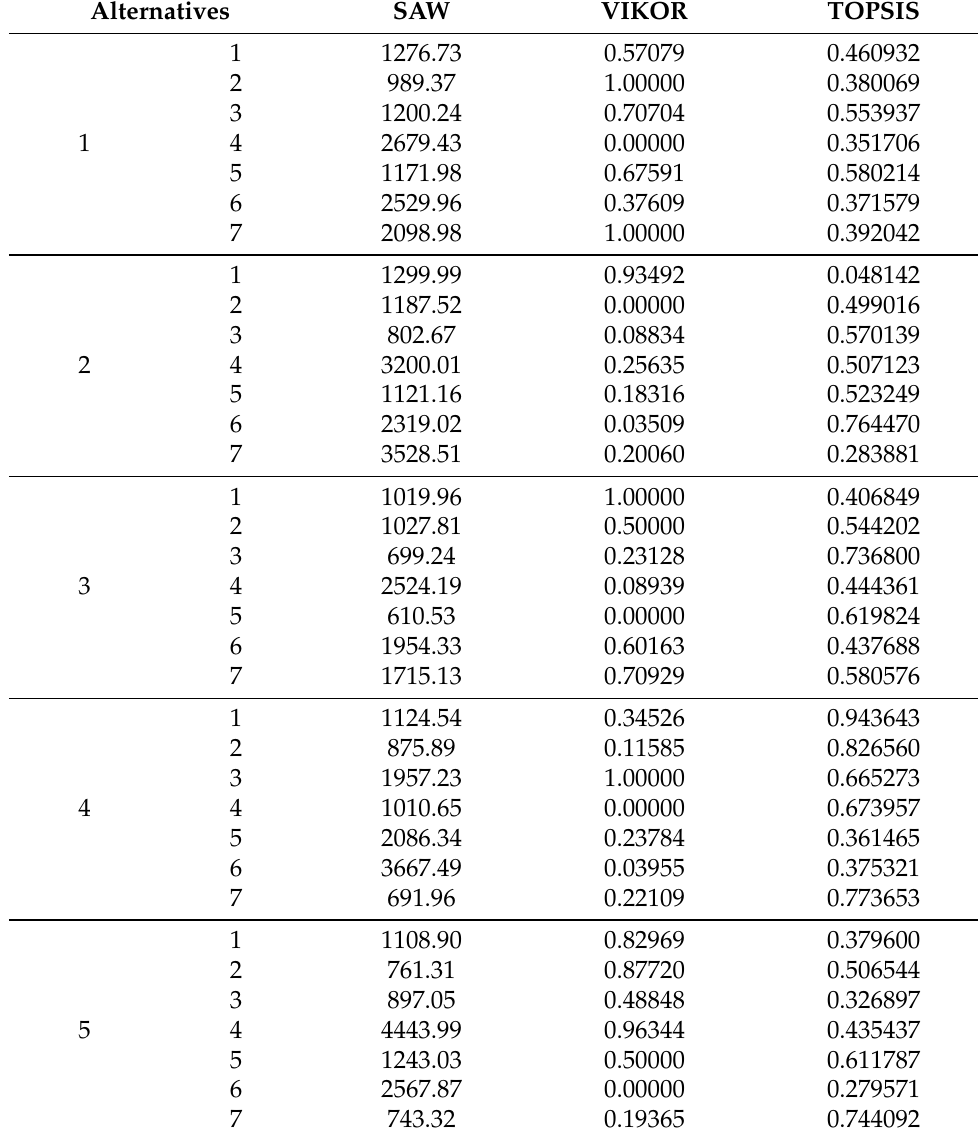
Figure 8. Rank applied VIKOR algorithm for the network with 22 and 37 nodes. Table 4. Ranking